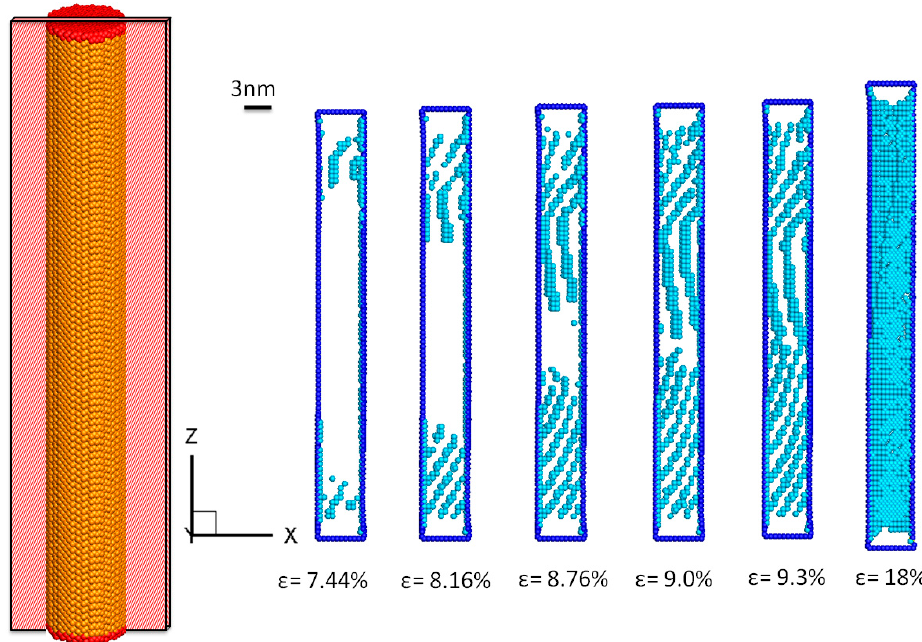
Figure 6. The lateral view of the cross-section at different strain levels ( ε = 7.44–18%). (cyan: meta-stable phase with CN = 5).